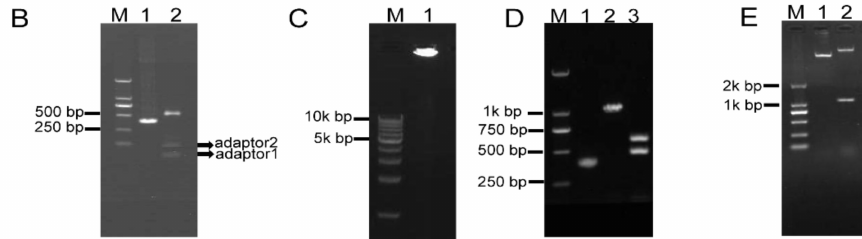
Figure 2. RCA-mediated construction of PDS ihpRNA. ( A ) Amplification and cloning into pKan- Bsa I. A 400-bp PDS fragment was amplified using the PDS-F and PDS-R primers (lane 1), followed by T-A cloning. Bsa I digestion indicates that a 450-bp PDS fragment was inserted into the pKAN- Bsa I vector (lane 2). ( B ) Formation of closed circular molecules. Bsa I-digested PDS fragment is shown in lane 1, ligation products between two adaptors and the Bsa I-digested PDS fragment are shown in the upper band in lane 2, and free adaptors are shown in the lower bands in lane 2. ( C ) Rolling